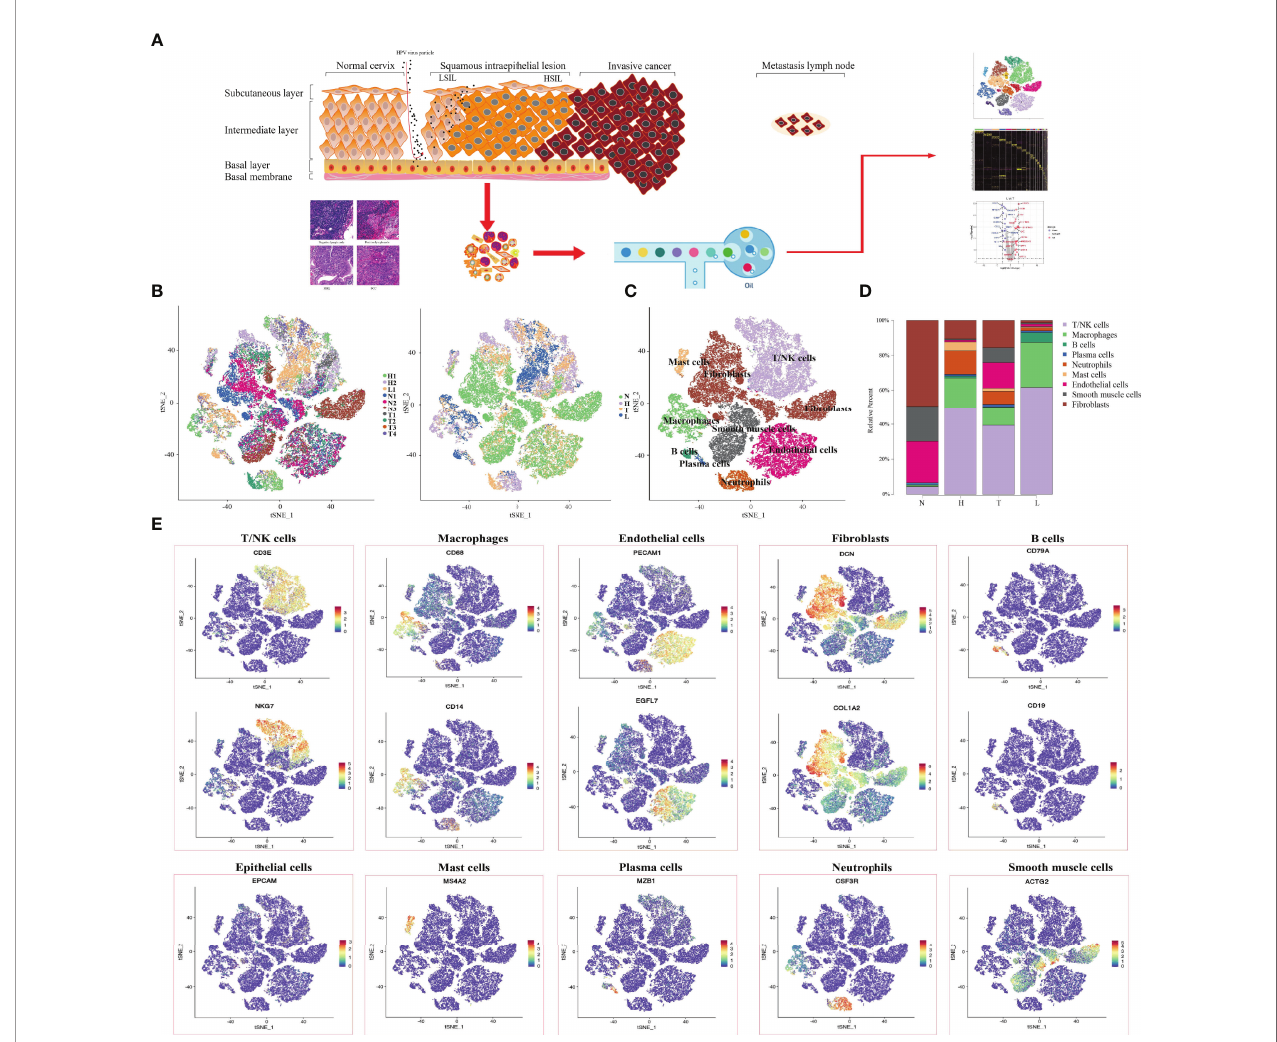
FIGURE 1 | Single-Cell pro fi ling of diverse immune cells from four groups (Normal cervix, HSIL, tumor and metastatic lymph nodes). Overview of the study work fl ow (A) . t-SNE plot and proportions of all cells annotated by the ten patients from four groups (B) . t-SNE plot of all cell types across samples from four groups (C) . Proportions of all cell types in each group (D) . Expression of cell-type-speci fi c marker genes illustrated in t-SNE plots (E)